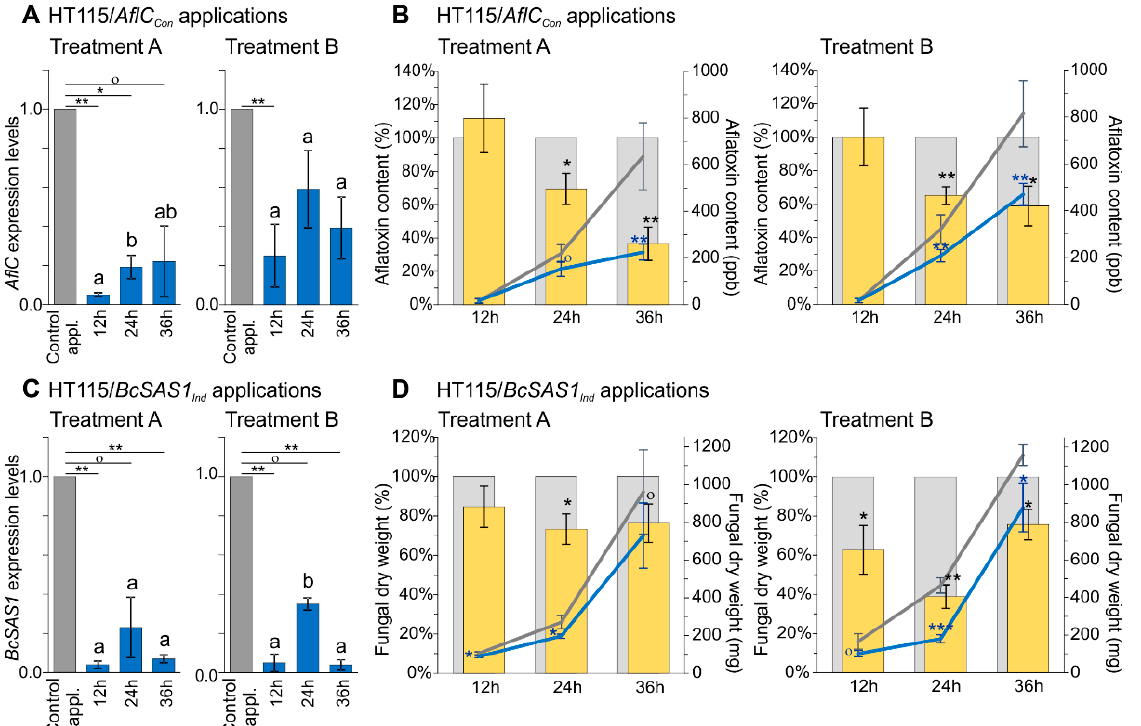
Figure 3. Increased contact times between fungi and dsRNA-producing bacteria have a positive effect on reducing production of aflatoxins in A. flavus and mycelial growth in B. cinerea . ( A , B ) AflC expression levels over time (Panel A) and the amount of aflatoxins produced by A. flavus (Panel B) in in vitro cultures of the fungus with living (Treatment A) or lysed (Treatment B) E. coli HT115(DE3) bacteria producing dsRNAs against AflC (HT115/ AflC Con ; test application) or eGFP (HT115/ eGFP Con ; control application). Living bacteria or their whole-cell autolysates, obtained from the OD 600 1.0 culture, were mixed with the fungal cultures, and AflC expression or the amount of aflatoxins in the co-cultures were measured at 12 h, 24 h, and 36 h. In Panel A, the expression levels of AflC in the test applications (blue bars) are shown relative to the control ones (grey bars, set to 1.0). Significant differences between control and test applications were determined by a one-way ANOVA followed by a Tukey’s HSD test, and levels of significance are indicated above the bars by underlined star symbols (i.e., o p < 0.1, * p < 0.05, ** p < 0.01). Differences in the gene silencing efficacy of AflC among the test applications were tested by ANOVA and a Tukey’s HSD test, and significantly different groups ( p < 0.05) are indicated by letters above the bars. In Panel B, yellow bars indicate the mean relative amount of aflatoxins produced by the fungus in the test relative to control applications, with the latter set to 100% and shown as the background grey bars. The slope analysis in Panel B shows the actual amount of aflatoxins in ppb produced over time by the fungus in control (grey lines) and test applications (blue lines). Error bars in Panels A and B indicate standard deviation (SD) obtained from three biological replicates. Significant differences in the relative mean amount of aflatoxins between control and test applications were determined by one-sample t -test, while significant differences in the absolute amount of aflatoxins were determined by a one-way ANOVA followed by a Tukey’s HSD test. Levels of significance are indicated above the bars by blue star symbols (i.e., o p < 0.1, * p < 0.05, ** p < 0.01). ( C , D ) Similar to Panels A and B, but showing BcSAS1 expression levels (Panel C) and the amount of biomass produced by B. cinerea (Panel D) over time in in vitro cultures of the fungus with living (Treatment A) or lysed (Treatment B) E. coli HT115(DE3) bacteria producing dsRNAs against BcSAS1 (HT115/ BcSAS1 Ind ; test application) or eGFP (HT115/ eGFP Ind ; control application).